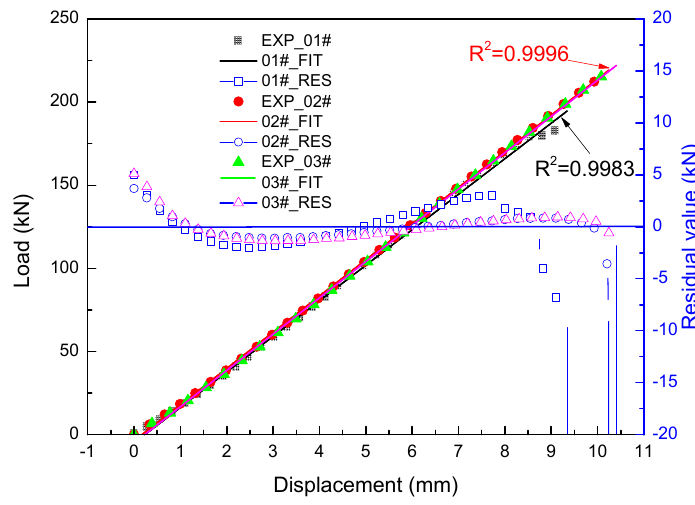
Figure 14. Load vs. displacement curves linear fitting and regular residual value curves.